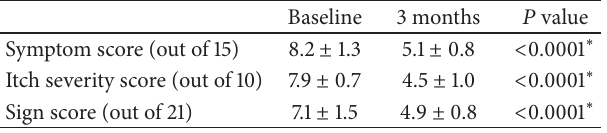
Table 3: Disease scores at baseline versus 3 months after